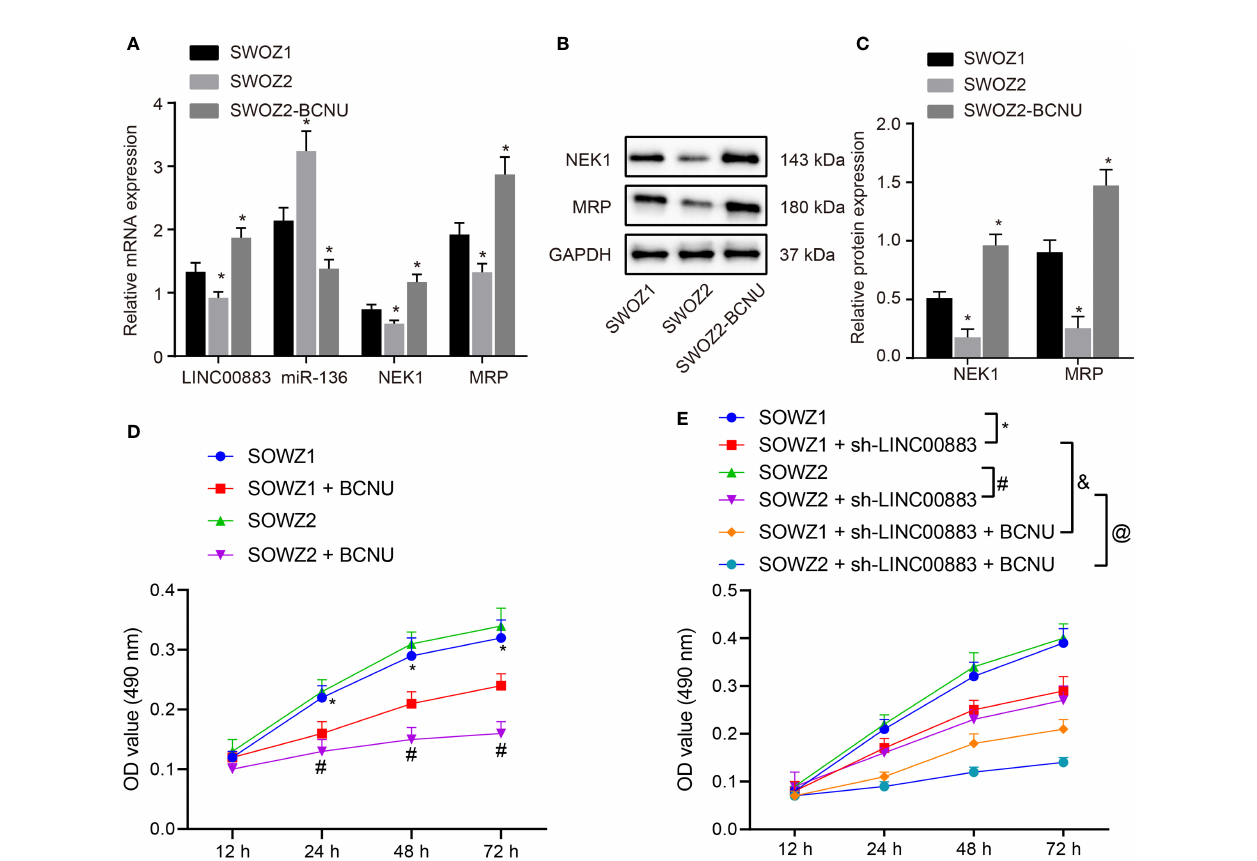
FIGURE 6 | LINC00883 silencing inhibits the viability of drug-resistant glioma cells. (A) The expression of LINC00883, miR-136, NIMA-related kinase 1 (NEK1) mRNA, and multidrug resistance-associated protein (MRP) mRNA in cell lines SWOZ1, SWOZ2, and SWOZ2-BCNU as detected by RT-qPCR. (B) The protein bands of NEK1, MRP, and GAPDH in cell lines SWOZ1, SWOZ2, and SWOZ2-BCNU as examined by Western blot analysis. (C) The protein levels of NEK1 and MRP in cell lines SWOZ1, SWOZ2, and SWOZ2-BCNU as examined by Western blot analysis. (D) The viability of SWOZ1, SWOZ2, and SWOZ2-BCNU cells after BCNU treatment as examined by 3-(4,5-dimethylthiazol-2-yl)-2,5-diphenyltetrazolium bromide (MTT) assay. (E) The viability of cell lines SWOZ1, SWOZ2, and SWOZ2-BCNU treated with BCNU after LINC00883 silencing as examined by MTT assay. * p < 0.05 vs . the SWOZ1 cell line; # p < 0.05 vs . the SOWZ2 cell line; & p < 0.05 vs . the SOWZ1 + sh-LINC00883 group; @ p < 0.05 vs . the SOWZ2 + sh-LINC00883 group. The results of RT-qPCR, Western blot analysis, and MTT assay were measurement data, which were expressed as mean ± standard deviation. The results of RT-qPCR and Western blot analysis were analyzed by one-way analysis of variance, and the results of MTT assay were analyzed by repeated-measures analysis of variance. Biological and technical experimental replicates were performed in